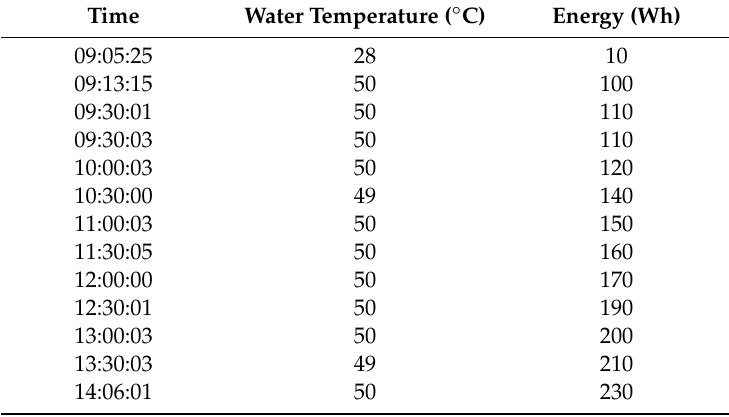
Table 2. Sample values that highlight the geyser performance during the absence of solar